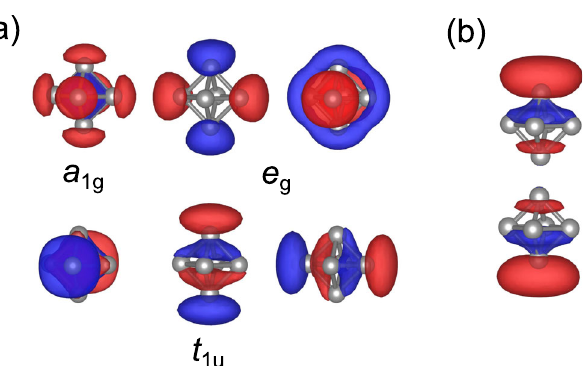
Fig. 2(b). Their asymmetric shape clearly indicates p - s mixing: